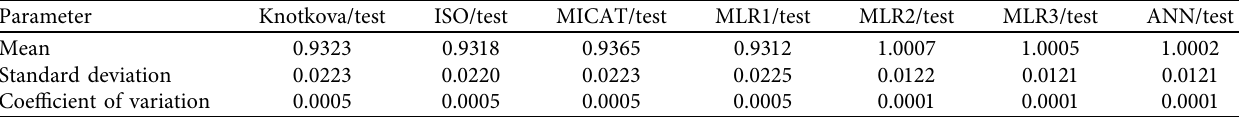
Table 5: Statistical characteristics of different predicted models, in which they are normalized with the test result.